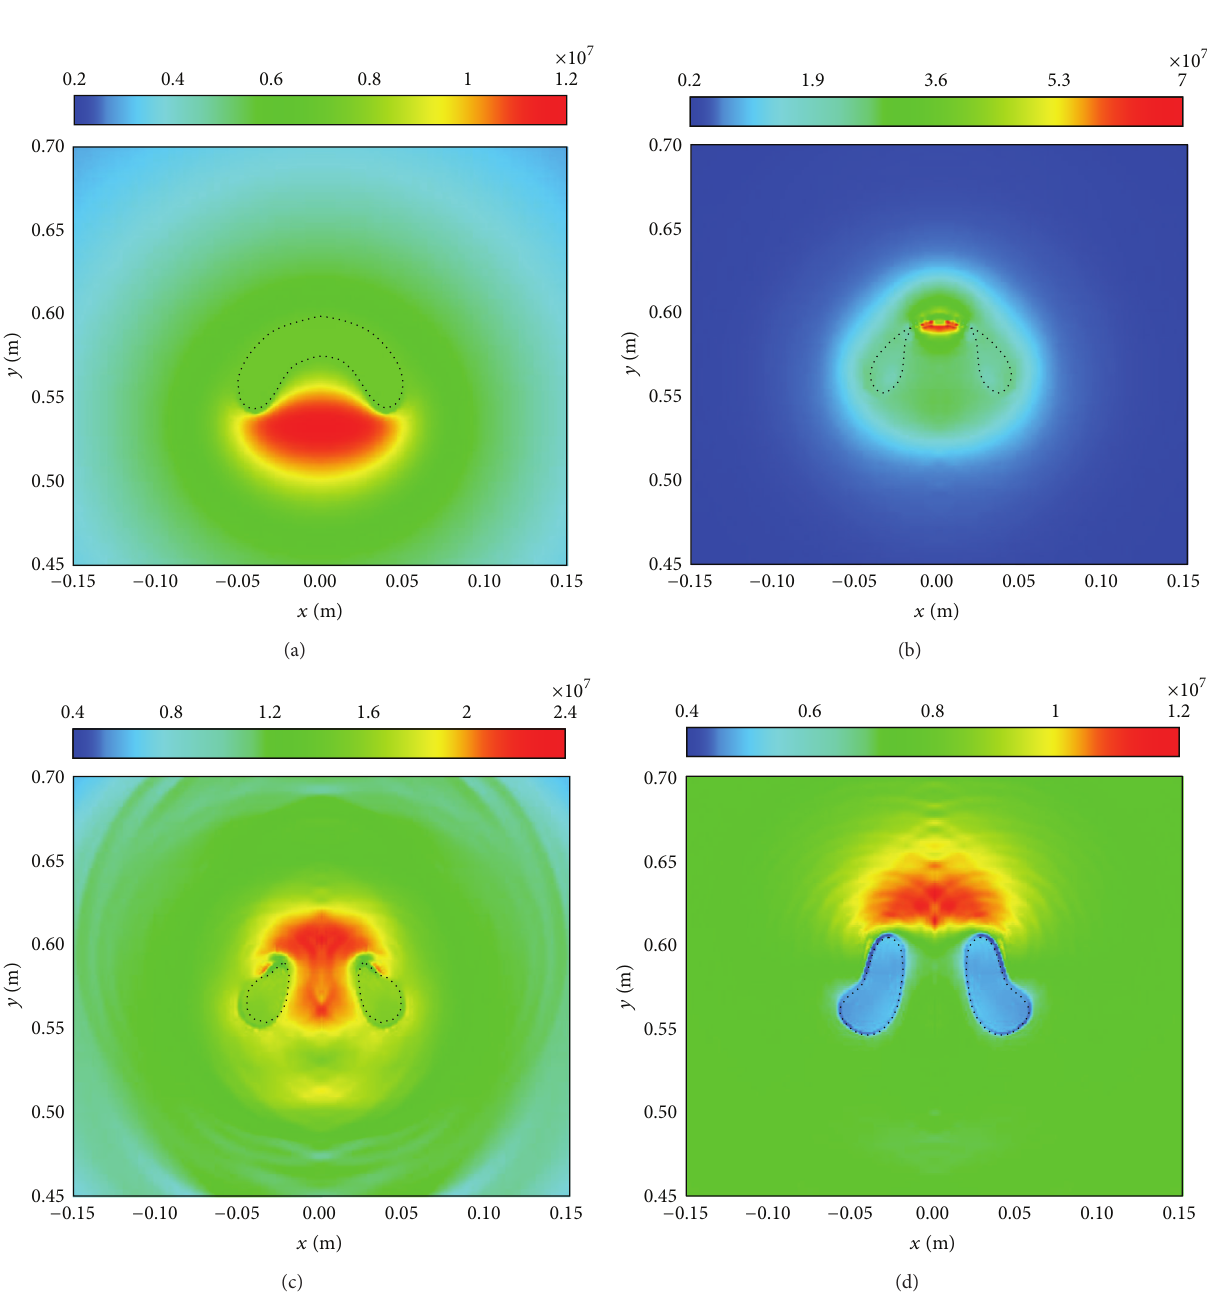
Figure 8: Pressure nephograms during bubble jet phase (from left to right the times are (a) 44.69 ms, (b) 44.82 ms, (c) 44.95 ms, and (d) 45.08